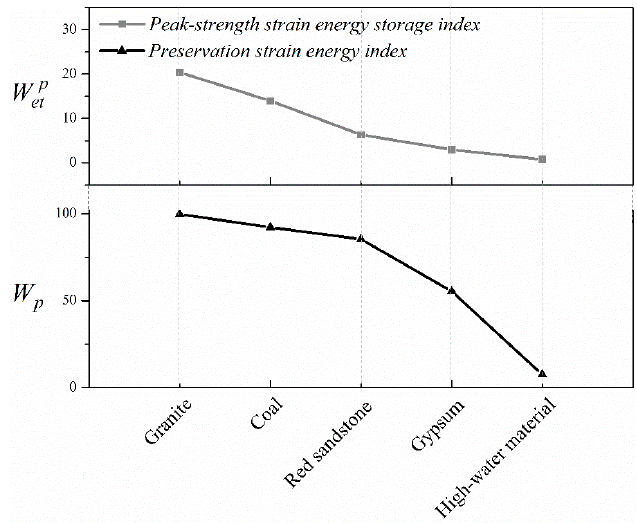
Figure 12. Energies 2020 , 13 , x FOR PEER REVIEW